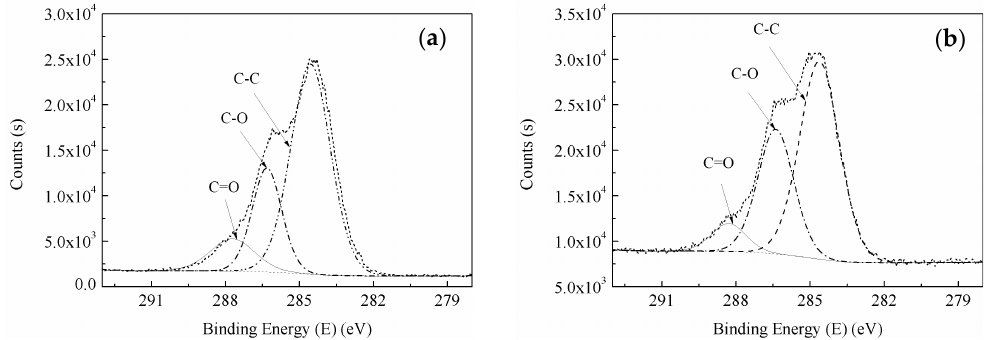
Figure 11. Curve fit of C1’s photoelectron peak of the BF: ( a ) untreated; ( b ) RES-treated.